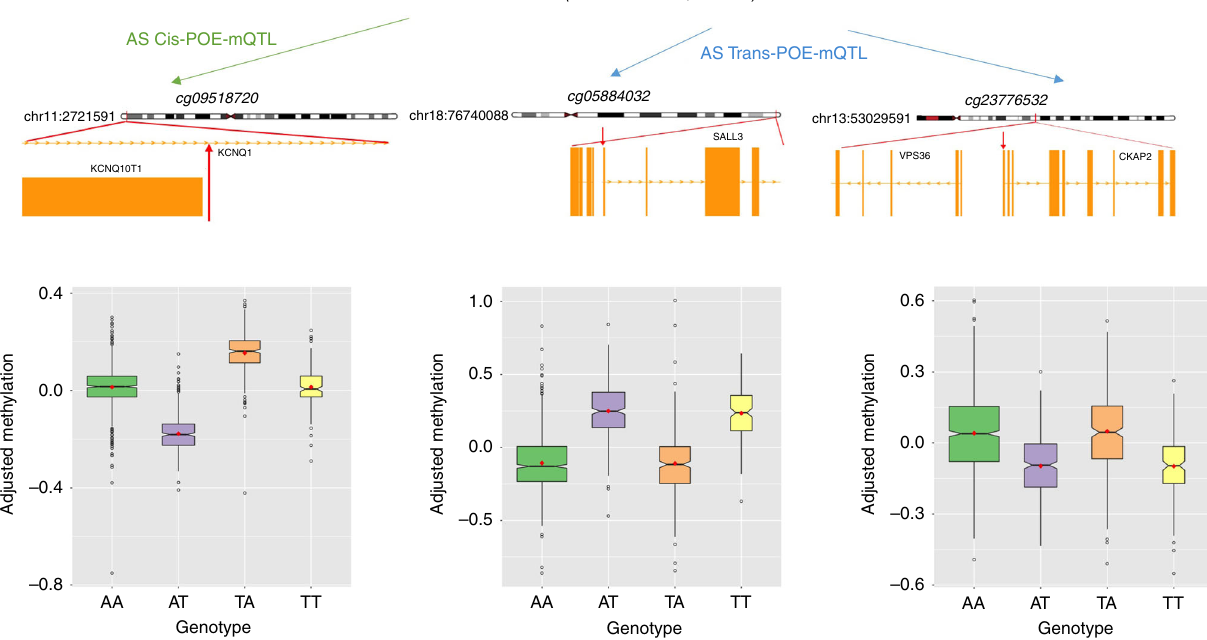
Fig. 4 Methylation CpGs regulated by SNP rs231356. SNP rs231356 acts both as a cis -POE – mQTL and a trans -POE – mQTL. Red arrows: location of the CpG in the chromosome. Boxplots show the allelic effects of rs231356 on methylation of three CpG sites (cg09518720, in cis , and cg05884032 and cg23776532, in trans ). Boxplots: centre line, median; box limits, upper and lower quartiles; whiskers, 1.5× interquartile range; points,